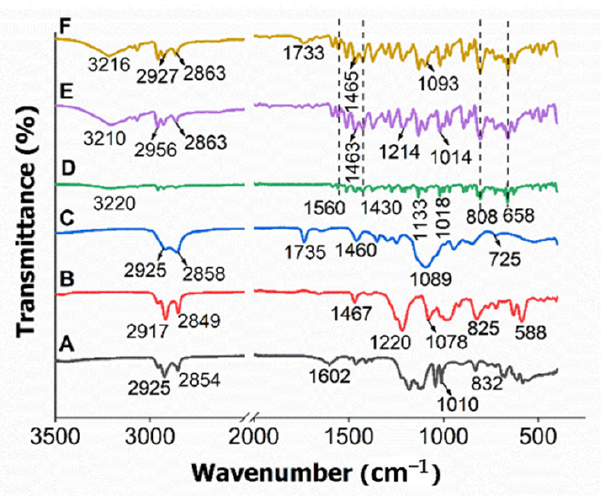
Figure 3. FTIR spectra of the physical mixture of SDBS ( A ), SDS ( B ), T80 ( C ), and their hexaconazole- micelle nanodelivery systems of HMBS ( D ), HMDS ( E ) and HMT ( F ). After the encapsulation of hexaconazole into the micelle of the surfactant, four char- acteristic peaks of hexaconazole; C=N, aromatic ring structure, C-H bend and a strong C-Cl stretching band at 1560, 1430, 808 and 658 cm − 1 , respectively, were observed in all the three micelle systems, as shown in Figure 3D–F, respectively. These bands indicate the formation of the nanodelivery system, where hexaconazole was encapsulated into the surfactant-micelles. The first broad band shown by each micelle system was shifted between 3210–3220 cm − 1 , possibly due to the weak electrostatic force of the attachment of ions from the hexaconazole moiety with H atoms of the hydroxyl group. HMBS spectrum (Figure 3D) also shows the SDBS presence; the C-H bending of benzene is observed at 1133 and 1018 cm − 1 . The band intensity of SDBS at 1184 cm − 1 is decreased, which may be due to the dissociation of the sulfonate group to forming the acyl group. This formation was observed when the HMBS sample exhibited a sharp band at 1133 cm − 1 indicating the mixture of hexaconazole and SDBS has generated a bonding between carbonyl and carbon group (acyl group), automatically decreasing the intensity of the alkoxy group at 1043 cm − 1 where less of the alkyl group was bonded directly to the oxygen atoms. HMDS shows major bands of SDS surfactant at 2956 and 2863 cm − 1 , assigned to C-H bond vibration, 1463 cm − 1 for CH 2 stretching and bending mode and 1214 cm − 1 related group at 2927 and 2863 cm − 1 , C=O stretching at 1733 cm − 1 , C-H bending of methylene group at 1465 cm − 1 and C-O-C stretching at 1093 cm − 1 which are associated with the T80 surfactant (Figure 3F).